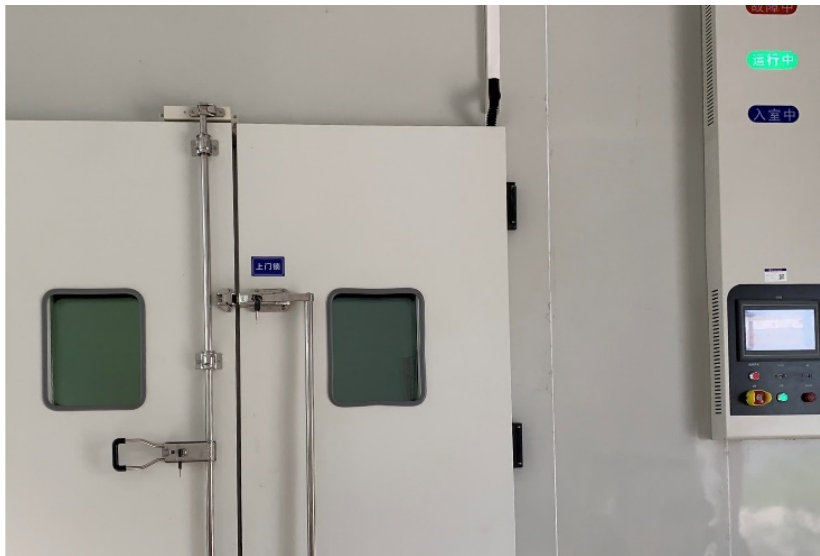
Figure 1. Climatic chamber rig.